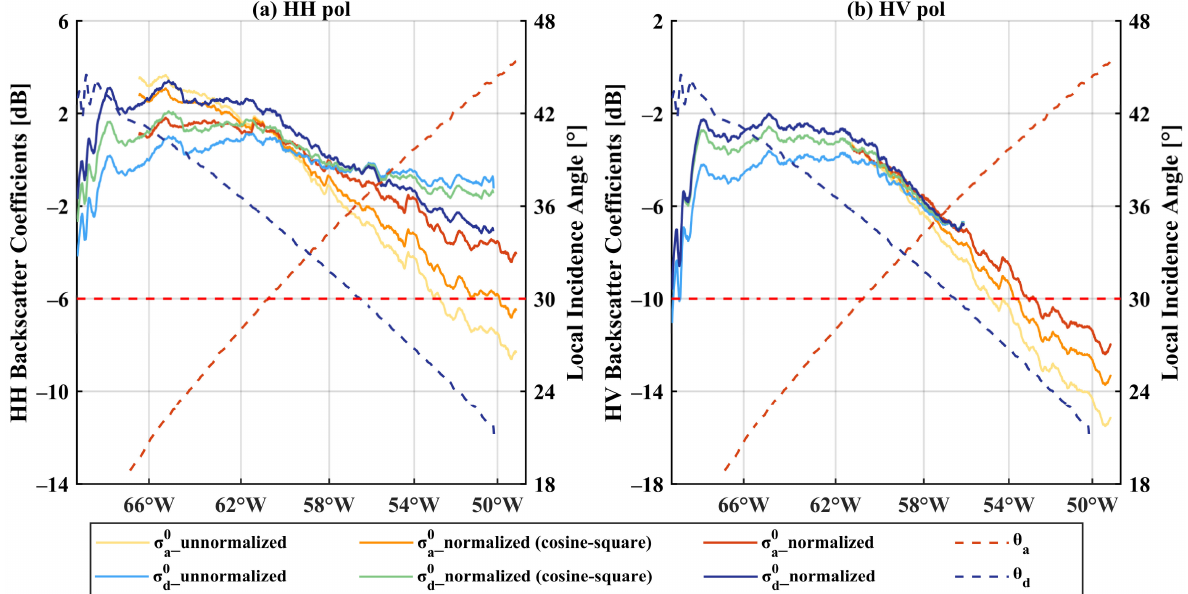
Figure 6. The profile obtained along the red line in Figure 5a of the backscatter coefficient before and after incidence angle normalization by the cosine-square method and the incidence angle correction method. The left vertical axis shows the backscatter coefficient variation and the right one shows the corresponding incidence angle change. The subscripts a and d refer to the ascending and descending images. The red dashed line indicates the reference incidence angle of 30 ◦